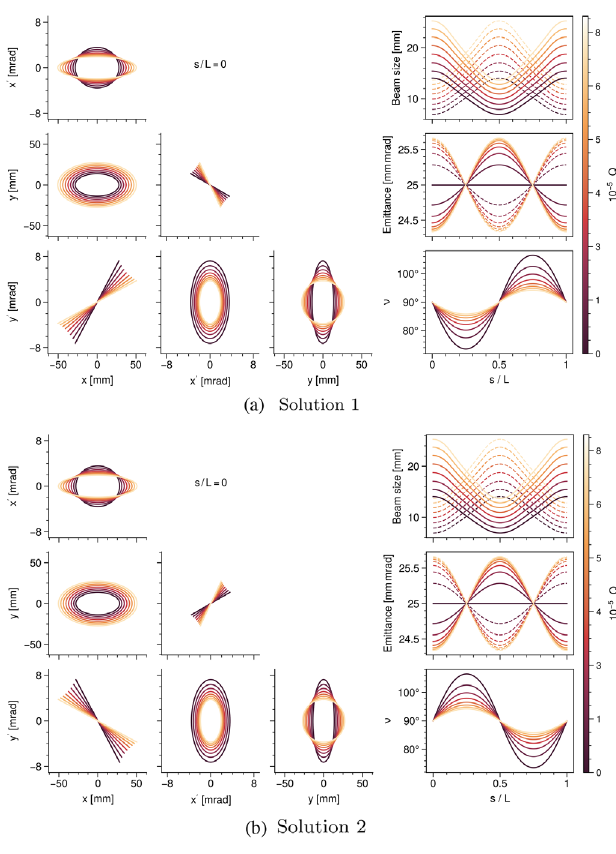
FIG. 8. Matched solution in an uncoupled FODO lattice as space charge is increased with (a) ε 2 ¼ 0 and (b) ε 1 ¼ 0 . Left: phase space projections at the lattice entrance. Right: beam parameters within the lattice. Solid lines are for x and dashed lines are for y in the top two